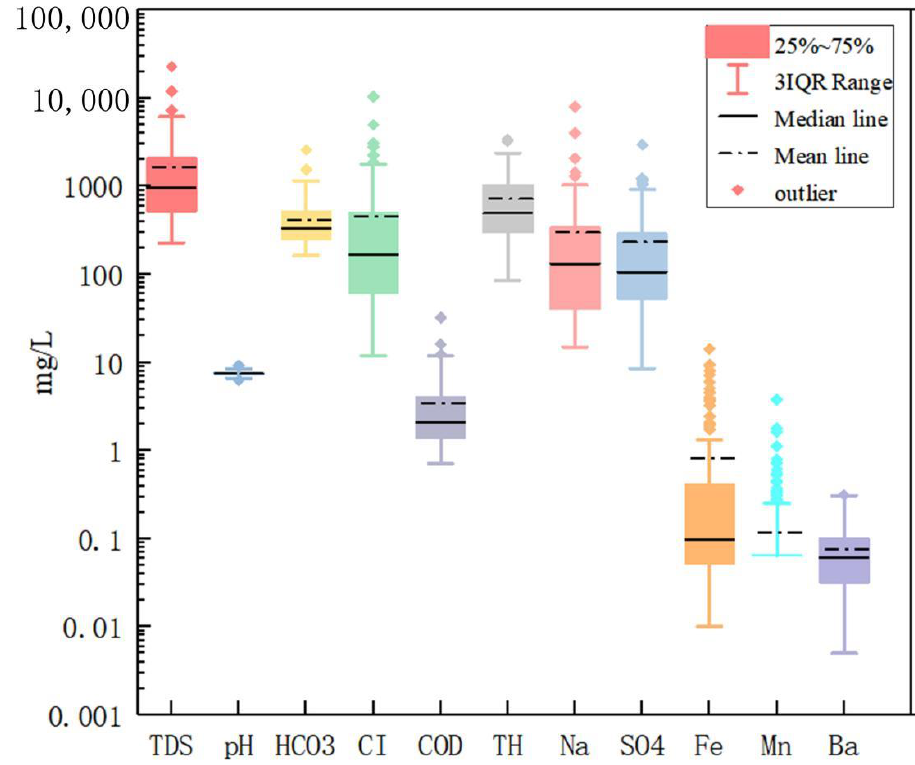
Figure 9. Box diagram of chemical composition of